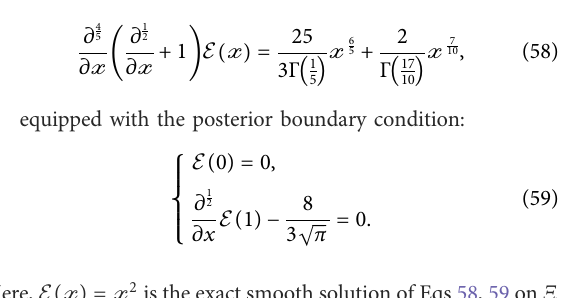
Algorithm 1, Algorithm 2, Algorithm